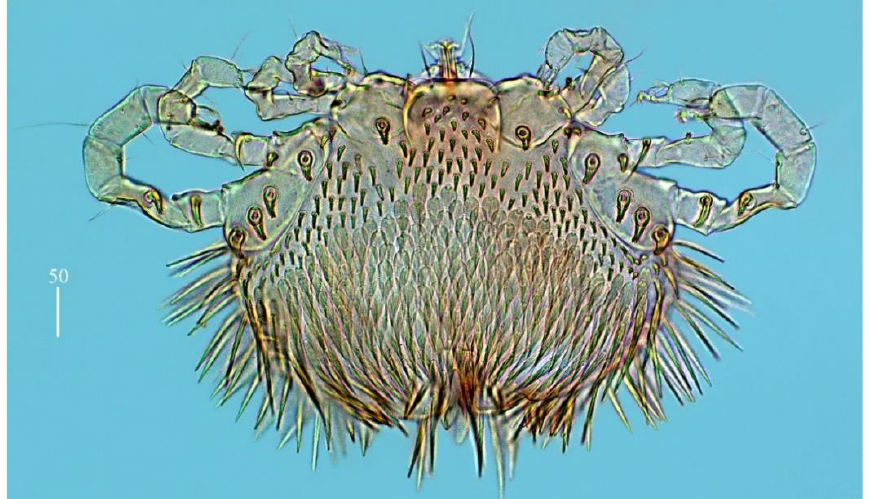
Figure 23. Geckobia phillipinensis Lawrence, 1953 female in dorsal view.